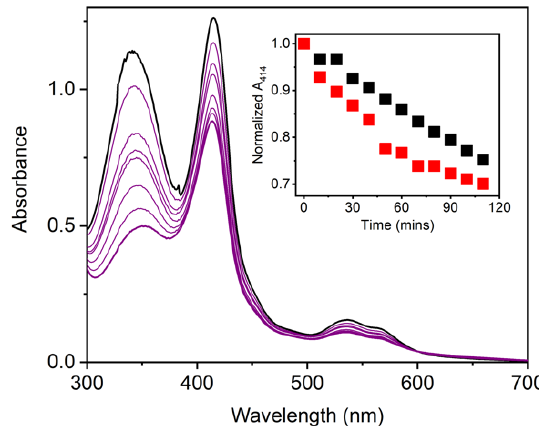
Figure 8. Heme degradation assay. UV–vis spectra showing heme degradation over time in the H111A variant (10 µ M). The inset shows the optical absorption at 414 nm as a function of time (min) during the heme degradation reactions in wild-type HupZ ( black squares ) and the H111A variant ( red circles ).